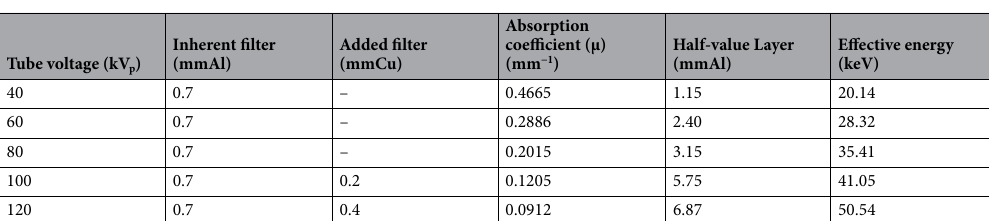
Table 2. Comparison of effective energy to tube